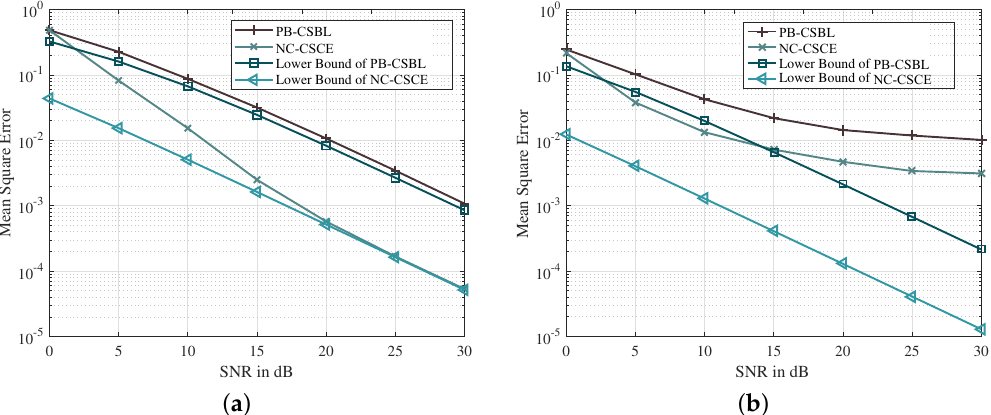
Figure 5. The MSE performance of the proposed algorithms and their theoretical lower bounds: ( a ) the temporal correlation coefficient β = 0; and ( b ) the temporal correlation coefficient β = 1.